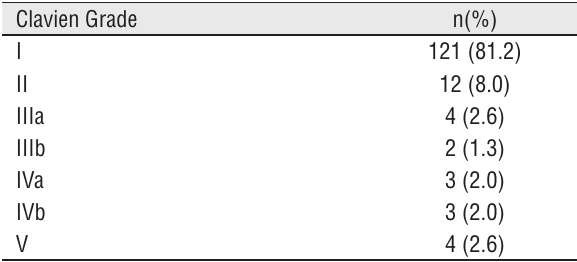
Table 2 - Postoperative complications